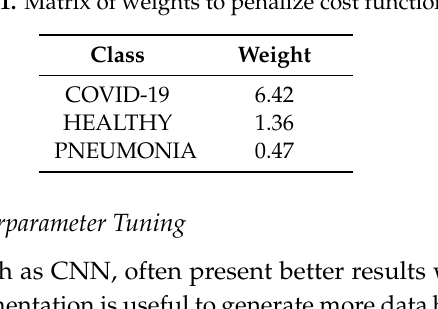
Table 1. Matrix of weights to penalize cost